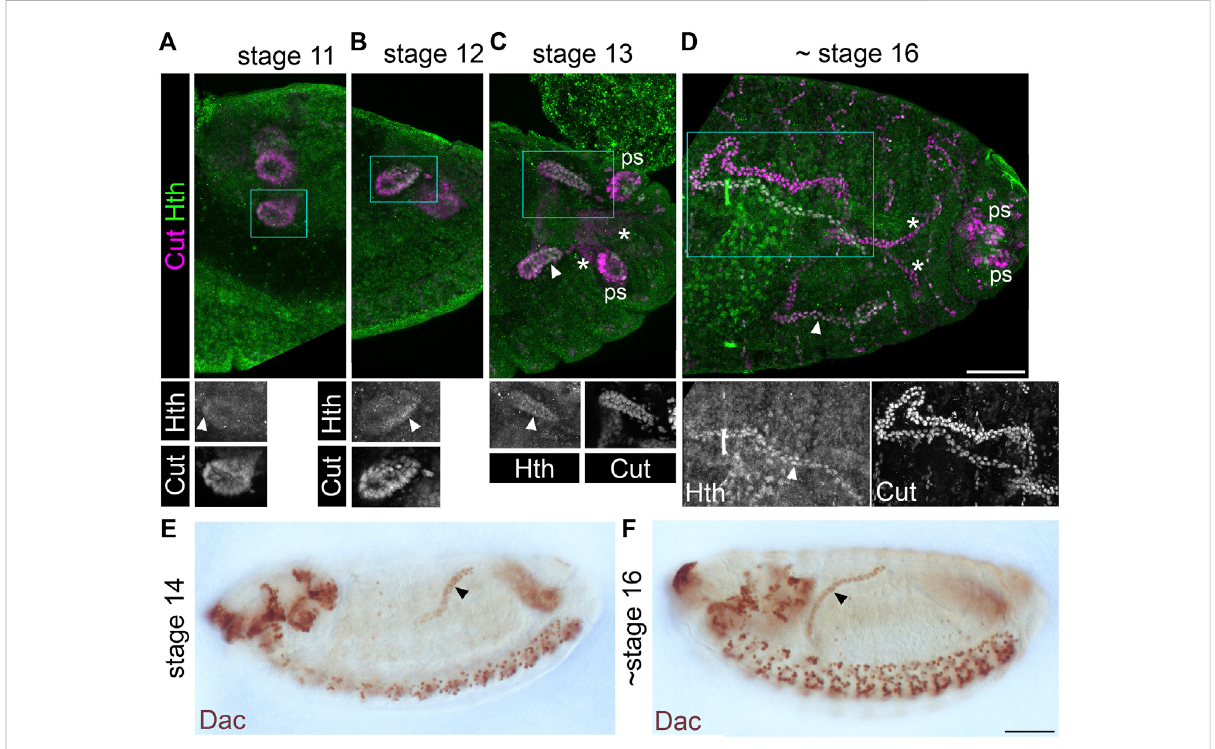
FIGURE 2 Homothorax and Dachshund are expressed in a distal domain of developing Malpighian tubules. (A-D) Stage 11 – 16 embryos (as indicated) stained with anti-Cut to show MpT nuclei, and with anti-Homothorax ( H th). Homothorax starts to be detectable in nuclei of the distal MpT from about stage 11 onwards (arrowheads). Single channel images equate to region in blue box of merged image. Posterior MpTs are also indicated (*), as are posterior spiracles (ps), which also express Cut and H th. Scale bar = 50 μ m. (E,F) Stage 14 – 16 embryos (as indicated) stained with anti- Dachshund. Scale bar = 50 μ